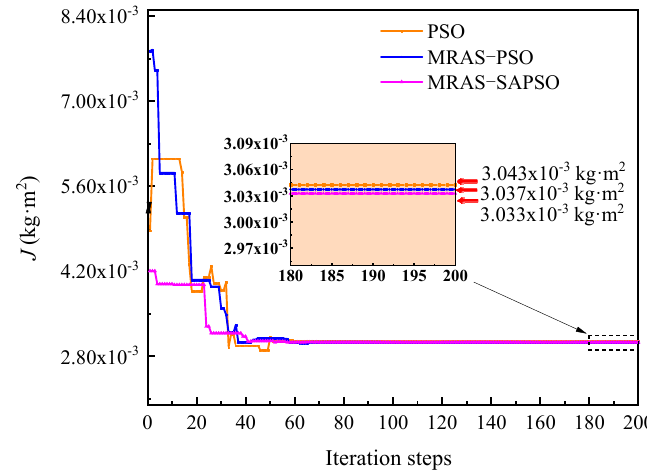
Figure 6. Magnetic linkage identification curve.